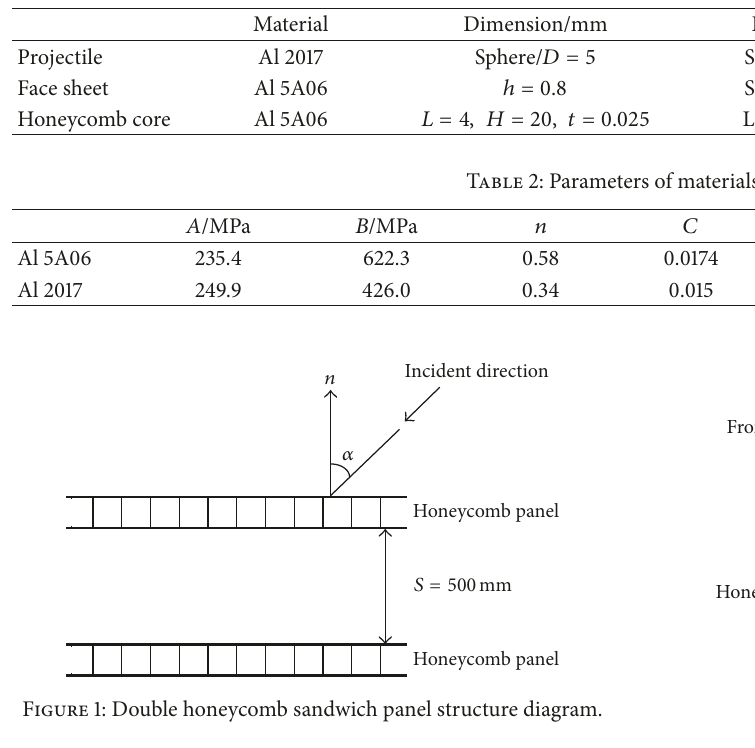
Table 1: Description of the simulation model.